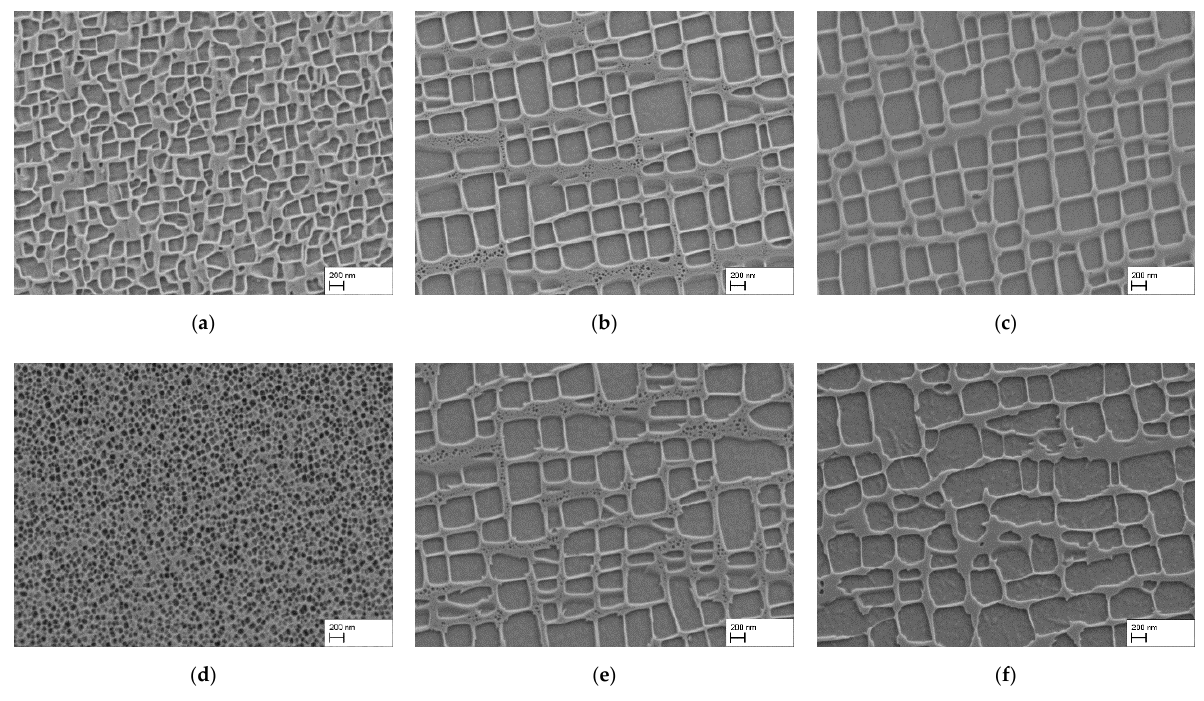
Figure 1. γ / γ′ -microstructure after homogenization and precipitation heat treatments: ( a ) HT/AC, ( b ) HT/AC + 1140 °C/6 h/AC, ( c ) HT/AC + 1140 °C/6 h/50 K/h cooling until 550 °C, ( d ) HT/WQ, ( e ) ◦ C/6 h/AC, ( c ) HT/AC + 1140 ◦ C/6 h/50 K/h cooling until 550 ◦ C, ( d ) HT/WQ, HT/WQ + 1140 °C/6 h/AC, ( f ) HT/WQ + 1140 °C/6 h/50 K/h cooling until 550 °C. ( b ) HT/AC + 1140 ( e ) HT/WQ + 1140 ◦ C/6 h/AC, ( f ) HT/WQ + 1140 ◦ C/6 h/50 K/h cooling until 550 ◦ C.